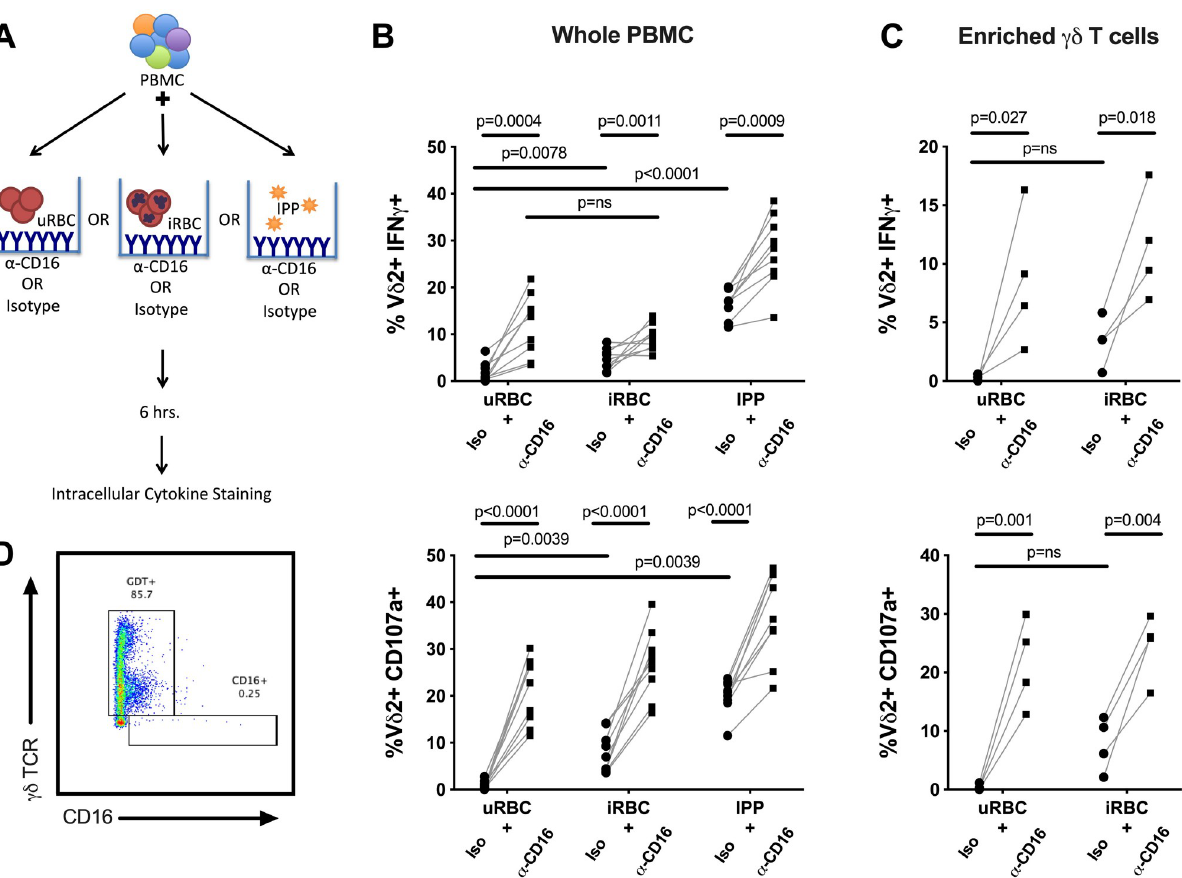
Fig 3. Stimulation through CD16 augments V δ 2 cell activation by P . falciparum . (A) Schematic detailing stimulation conditions for data presented in panel B. (B) Percent of V δ 2 T cells producing IFN γ or positive for CD107a after stimulation of whole PBMC with uRBC, iRBC or IPP, with or without plate bound anti-CD16 crosslinking antibody (n = 9). (C). Percent of V δ 2 T cells producing IFN γ or positive for CD107a after stimulation of negatively selected γδ T cells with uRBC or iRBC, with or without plate bound anti-CD16 crosslinking antibody (n = 4). (D) Live cells positive for γδ TCR after negative selection. All V δ 2+ T cells shown in B-C were gated on singlets and CD3+ events to exclude NK cells. Samples for these experiments were selected from individuals with greater than 30% of their V δ 2 T cells expressing CD16. P values were determined by Wilcoxon matched pairs signed rank